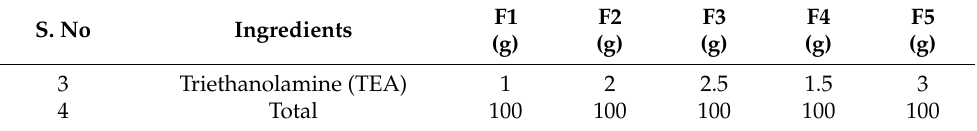
Table 3. Cont. S. No